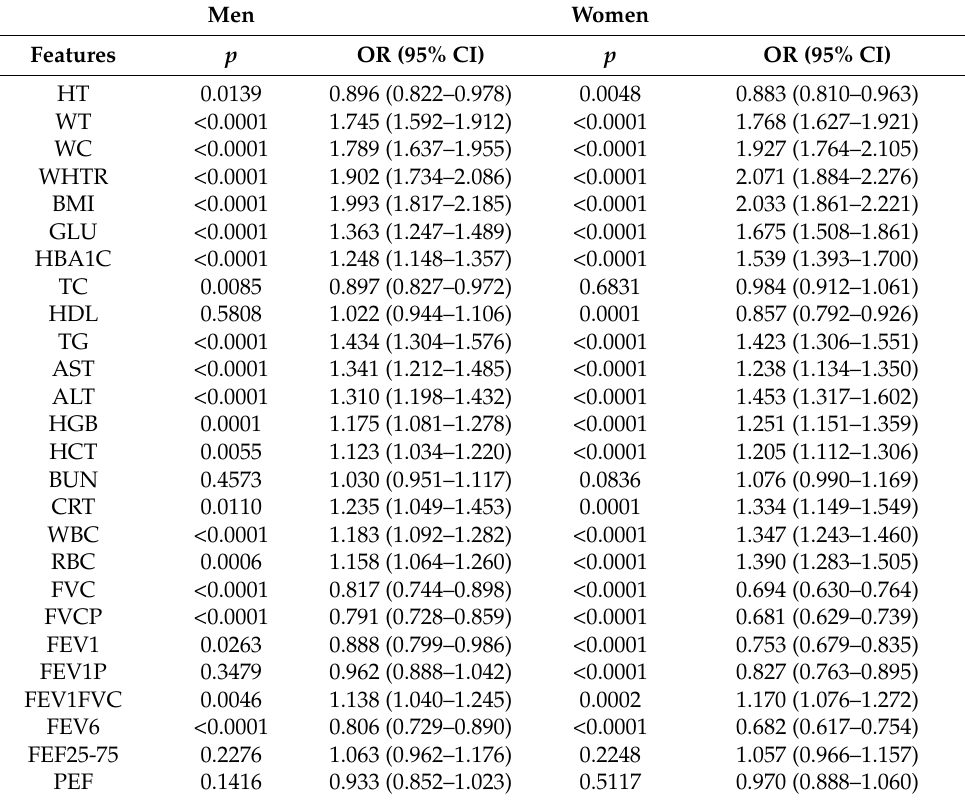
Table 3. Results of statistical analyses of differences between normotension and hypertension in men and women. Men